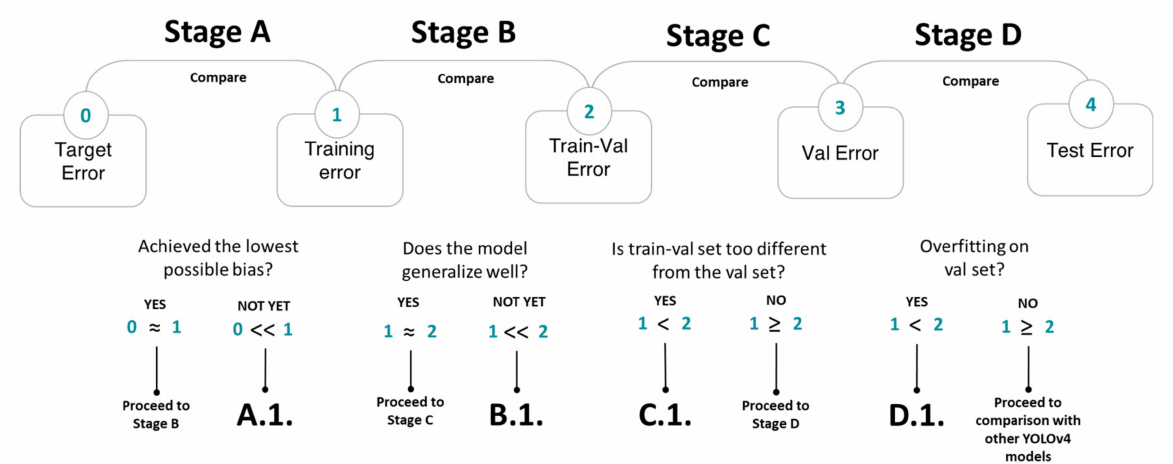
Figure 11. Error analysis to achieve the best possible performance for the model from Stage A to Stage D. The goal of the error analysis is to reduce the gap on each pair of errors by performing the strategies found in Table A4. The target error (also called Bayes error) is the lowest possible detection error, which in this case can be considered as the human error rate in detecting